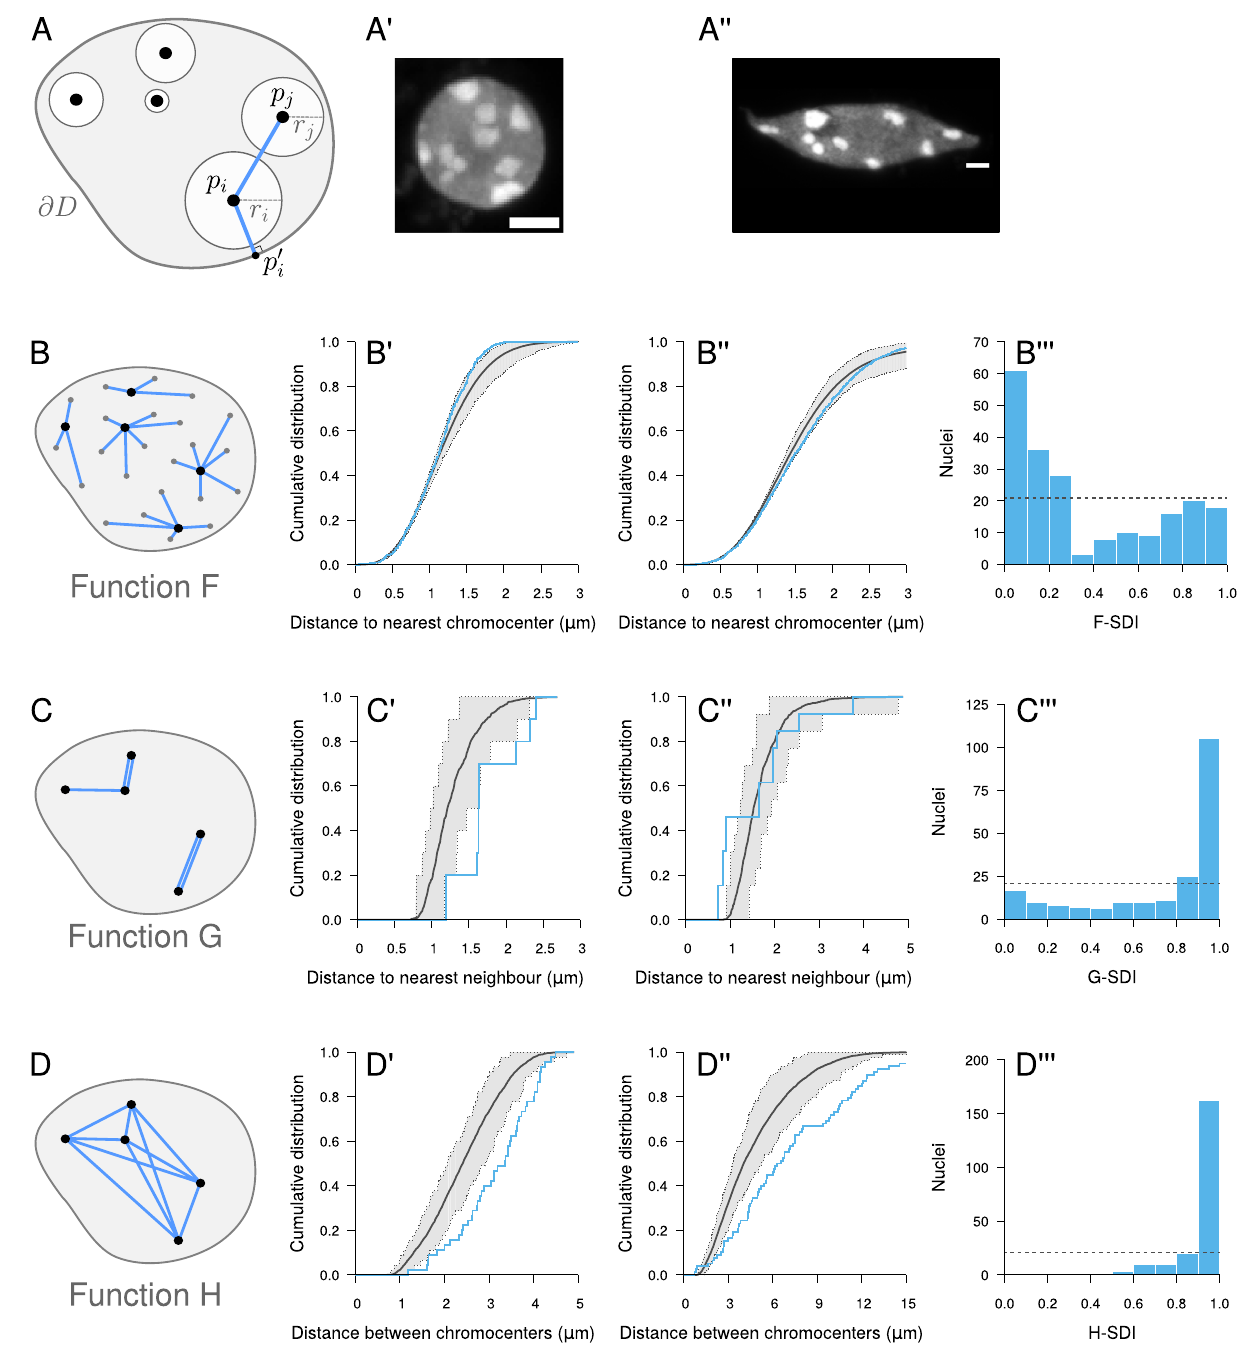
Figure 2. Completely random object distribution model and its application to chromocenters in A. thaliana cell nuclei. ( A ) Completely random object model in confined domain. Objects are placed at random positions, avoiding intersections with other objects or with domain boundary ∂ D . p i : centroid position of object i ; r i : equivalent radius of object i ; p ′ i : boundary point closest to p i . ( A ′ , A” ) Two sample nuclei from the analyzed population (scale bar: 5 µ m). ( B – D ) Distance measurements used to compute functions F , G , and H , respectively. Black dots : object centroids; Gray dots : space positions. ( B ′ , B” ) Measured ( Blue ) and model ( Black ) functions F in the two sample nuclei shown in ( A ′ , A” ). Dotted lines : lower and upper limit of the 95% envelope ( Grey ) under the model. ( B’’’ ) Distribution of the F -SDI in the population of nuclei. Dotted line : distribution expected under the completely random model. ( C ′ , C” , C’’’ ) Same as ( B ′ , B” , B’’’ ) with function G . ( D ′ , D” , D’’’ ) Same as ( B ′ , B” , B’’’ ) with function H